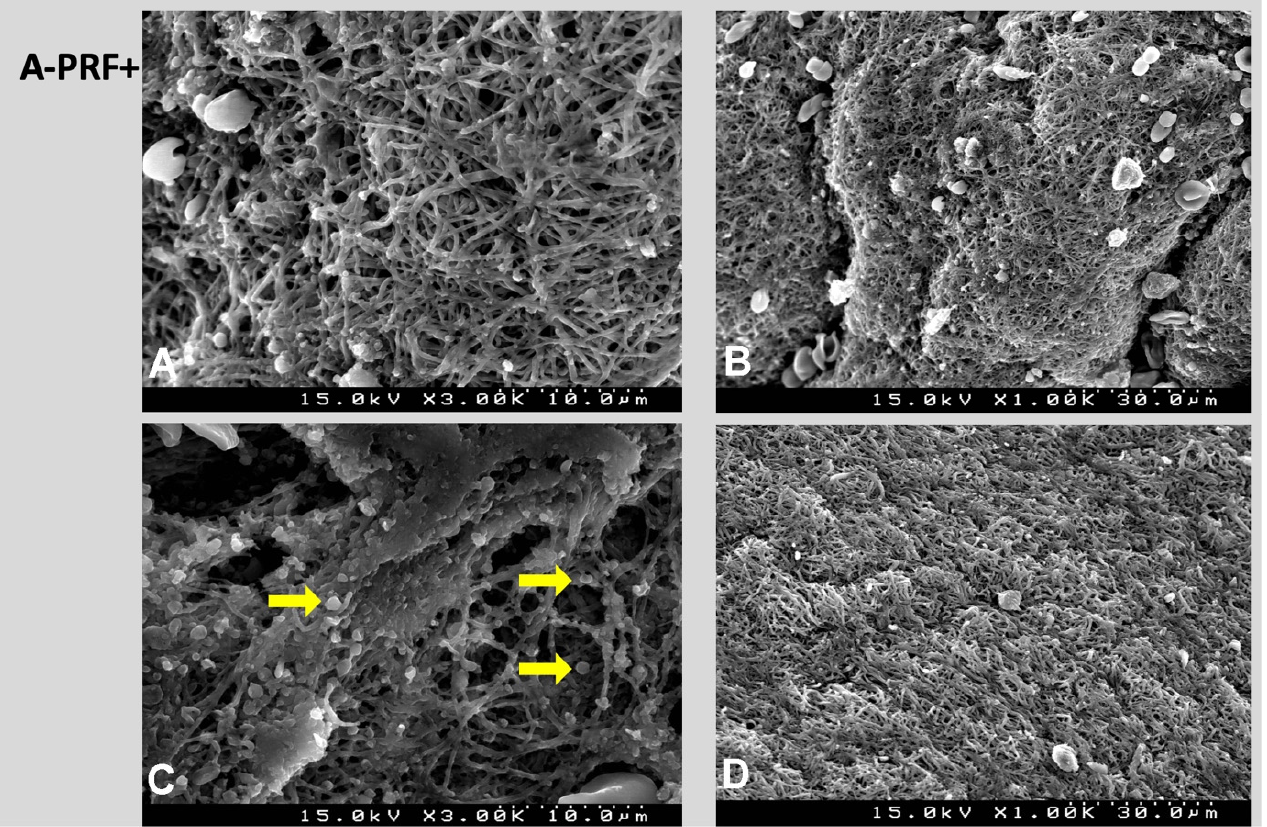
Figure 6. SEM images. A-PRF+ fibers and platelets together ( A ). It is possible to observe red cells and platelets adhering to the fibers (( B , C ), yellow arrow); ( D ) shows a more fibrotic portion characterized by the lower-upper area.